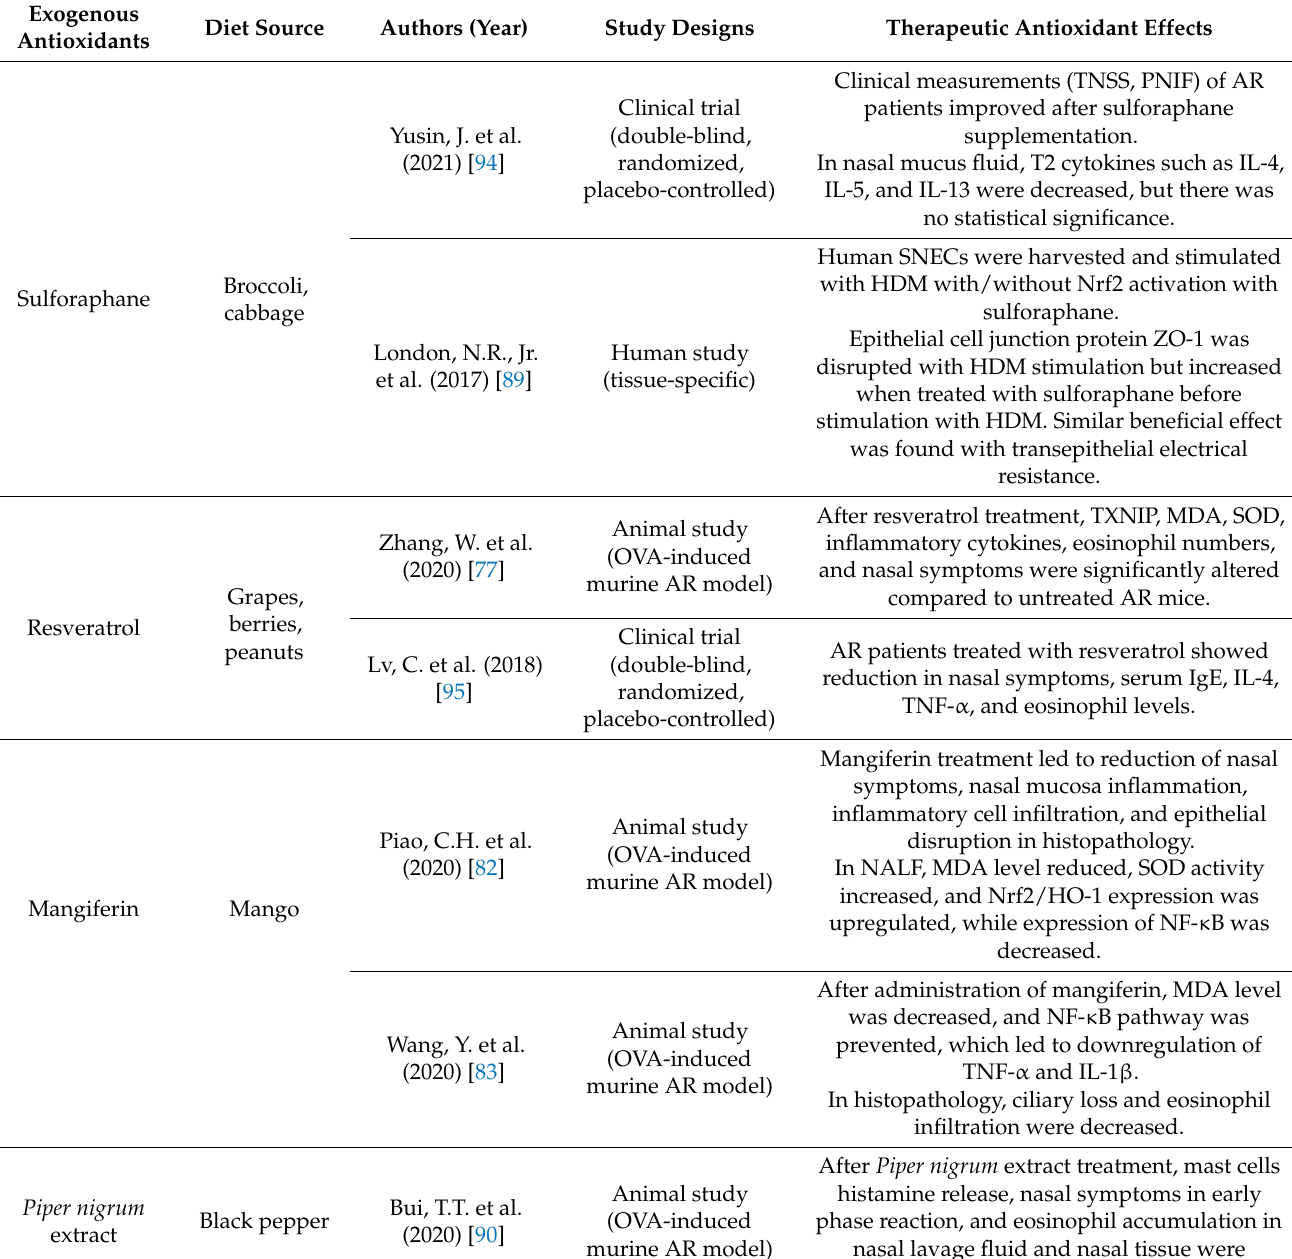
Table 1. Recent studies regarding the potential therapeutic antioxidants in relation to oxidative stress in allergic